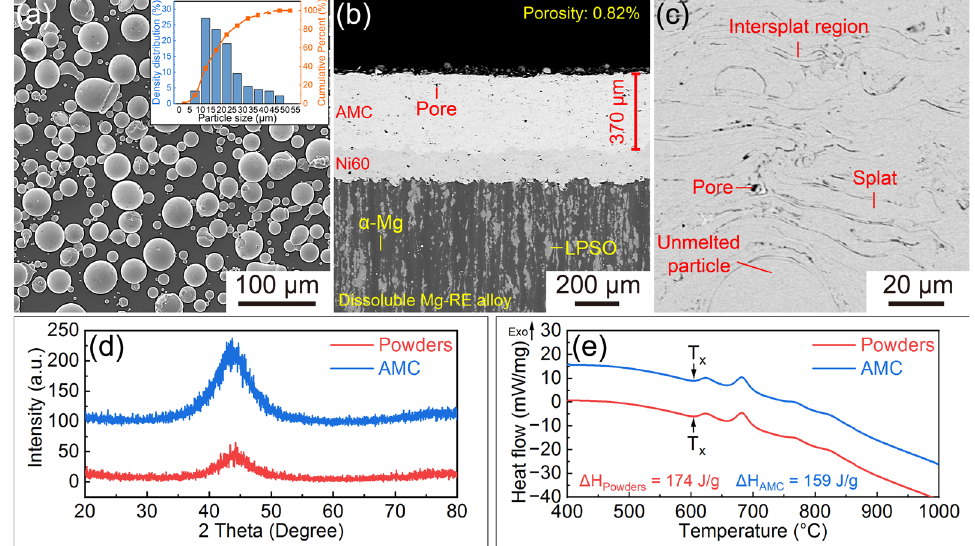
Figure 1. ( a ) SEM-SE image and size distribution of Fe-based amorphous powders; ( b , c ) Cross-sectional SEM-BSE images of the AMCs; XRD patterns ( d ) and DSC curves ( e ) of the Fe-based amorphous powders and AMCs.